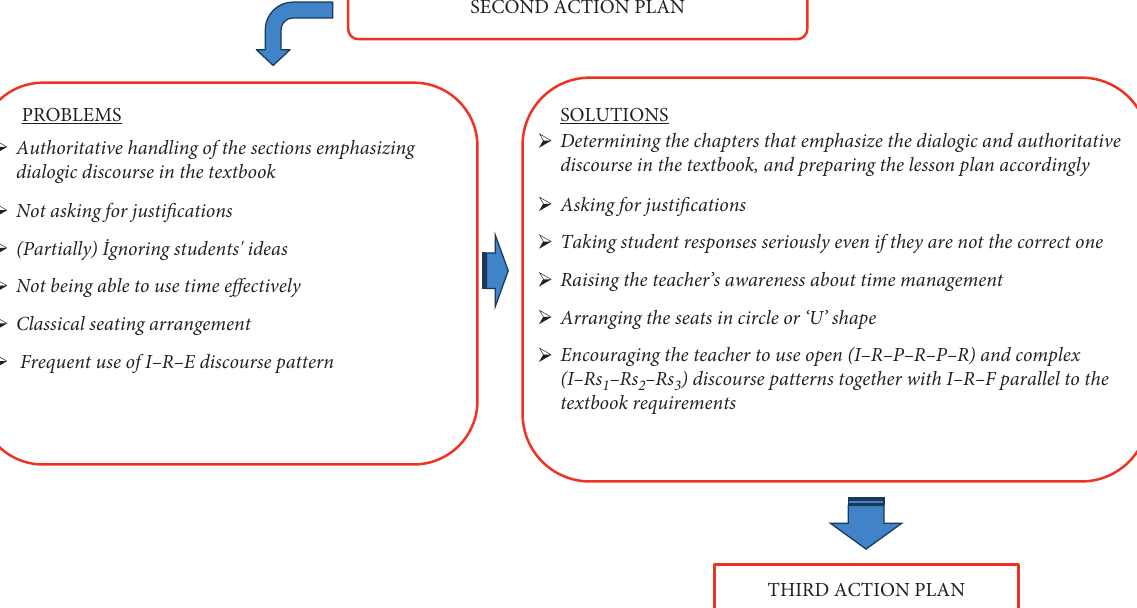
Figure 7: 2 nd action plan—problems and solutions.